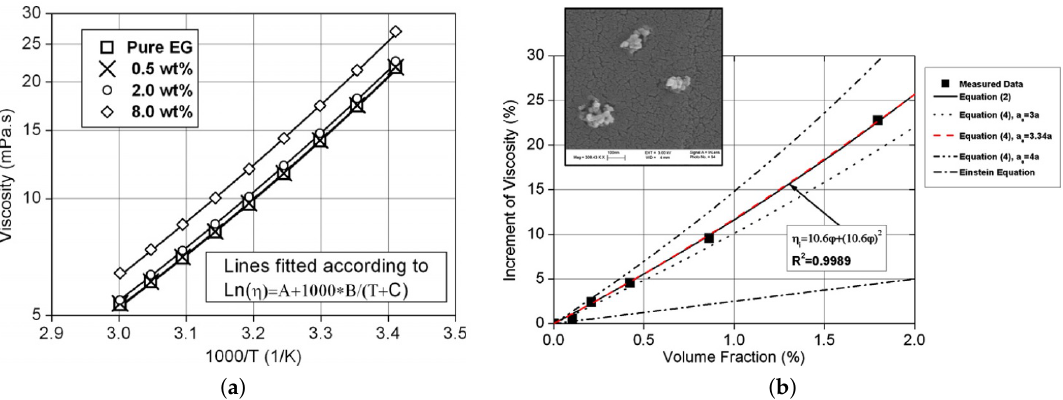
Figure 4. Influence of the ( a ) temperature and ( b ) nanofluid volume fraction on the dynamic viscosity of TiO 2 nanoparticles dispersed in pure ethylene-glycol. After [52], with permission from